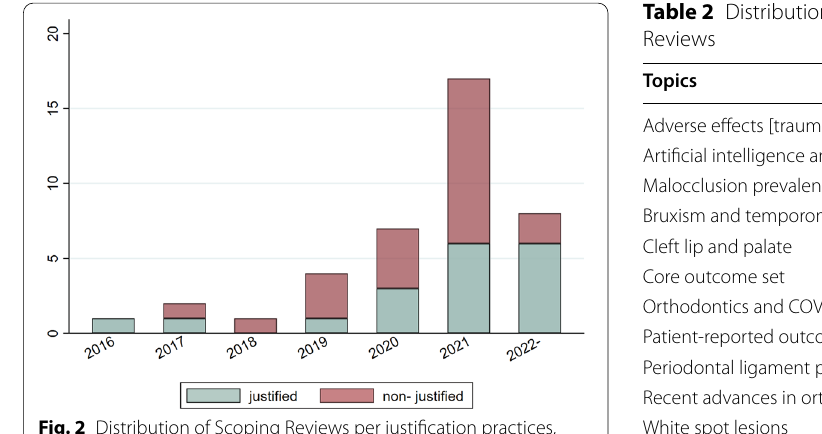
Table 2 Distribution of topics related to the included